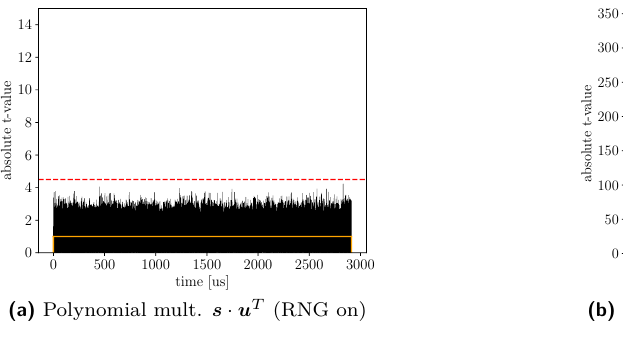
Figure 14: TVLA results for the linear polynomial multiplication s · u T given a total amount of 100k traces. The confidence interval ( t = 4 . 5) is shown as dotted red line, while the is trigger interval is given in